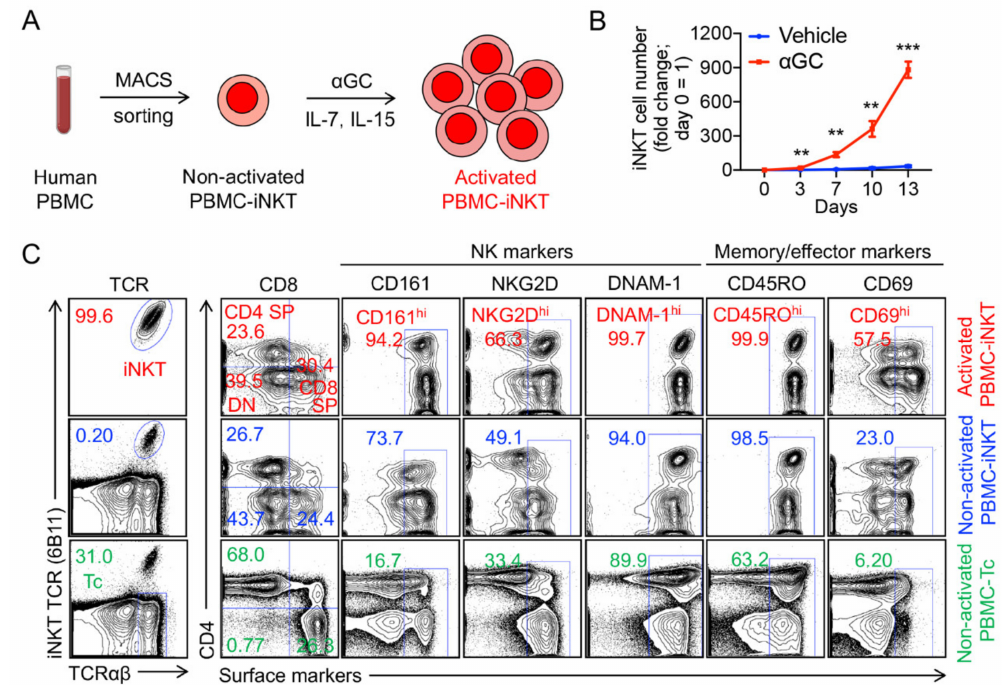
Figure 1. Generation of healthy donor peripheral blood mononuclear (PBMC)-derived iNKT (PBMC- iNKT) cells. ( A ) Experimental design to generate PBMC-iNKT cells in vitro. MACS, magnetic- activated cell sorting; α GC, α -galactosylceramide. ( B ) PBMC-iNKT cell growth curve post-antigen stimulation. PBMC-iNKT cells were cultured for 13 days in the presence or absence of α GC (denoted as α GC or Vehicle, respectively; n = 3). ( C ) FACS detection of surface markers on PBMC-iNKT cells. Non-activated PBMC-iNKT cells and non-activated PBMC-Tc cells were included as controls. Representative of three experiments. Data are presented as the mean ± SEM. ** p < 0.01; *** p < 0.001 by Student’s t